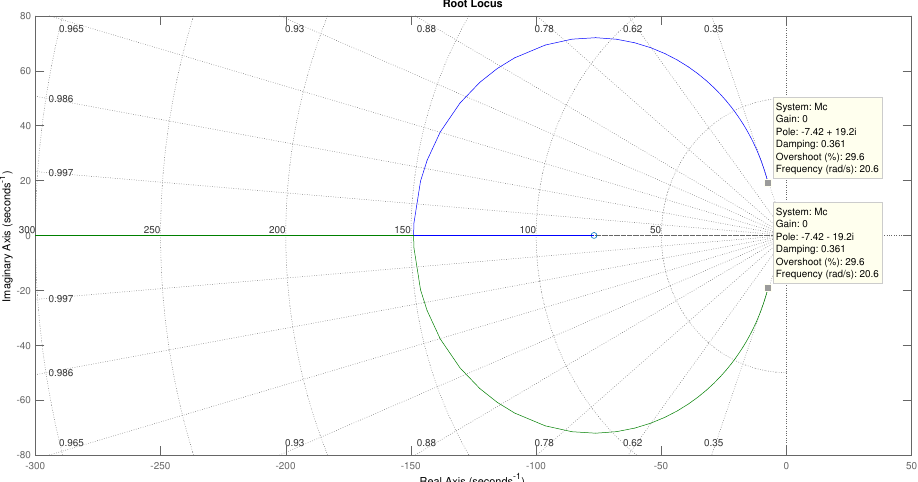
Figure 17. Locus of roots for the transfer function of a DC